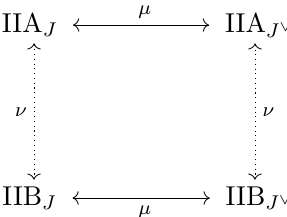
Figure 1 . Dualities for type II superstrings on a mirror pair of G 2 holonomy manifolds ( J; J _